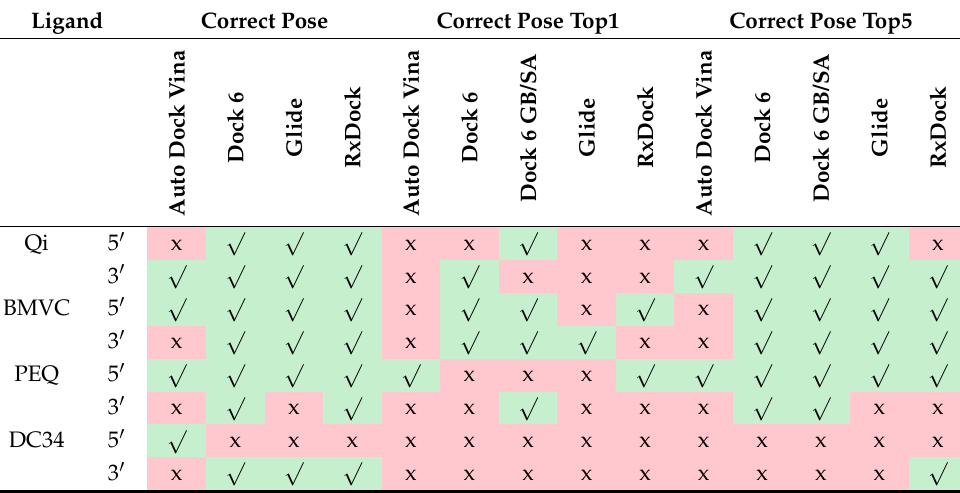
Table 5. Overall results of small molecule docking to MycG4 using different docking software 1 . Ligand Correct Pose Correct Pose